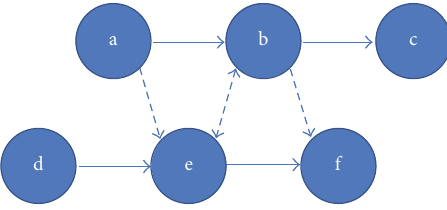
Figure 1: Example of using interference cancelation.